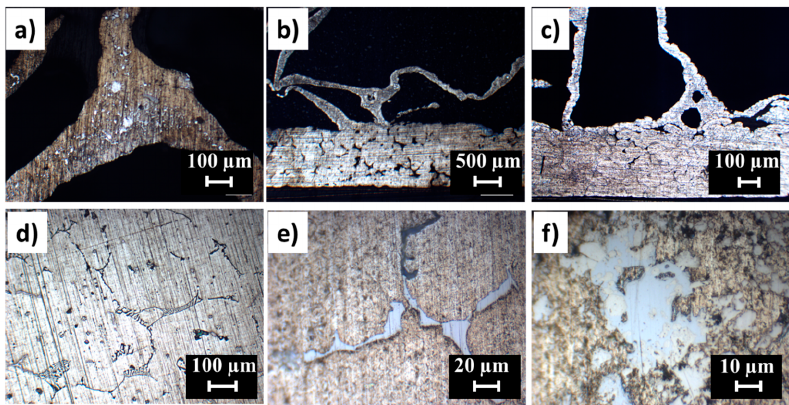
Figure 6. Macro- and micrographs, showing the Al-alloy sheet/Al-alloy foam joint produced using Al-Si-Mg-Ti amorphous alloy, ( a ) Al-alloy foam, ( b , c ) Al-alloy sheet/Al-alloy foam joint interface, and ( d – f ) Al-alloy sheet.